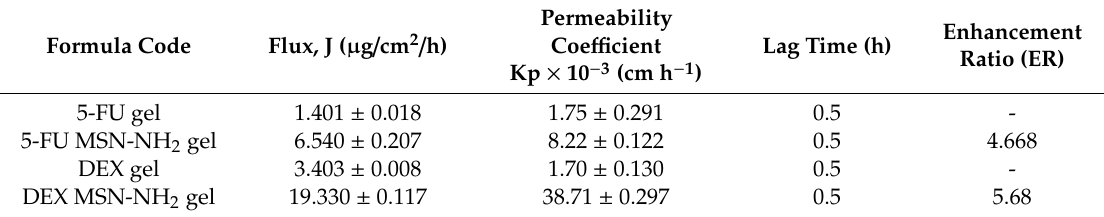
Table 4. Calculation of permeation